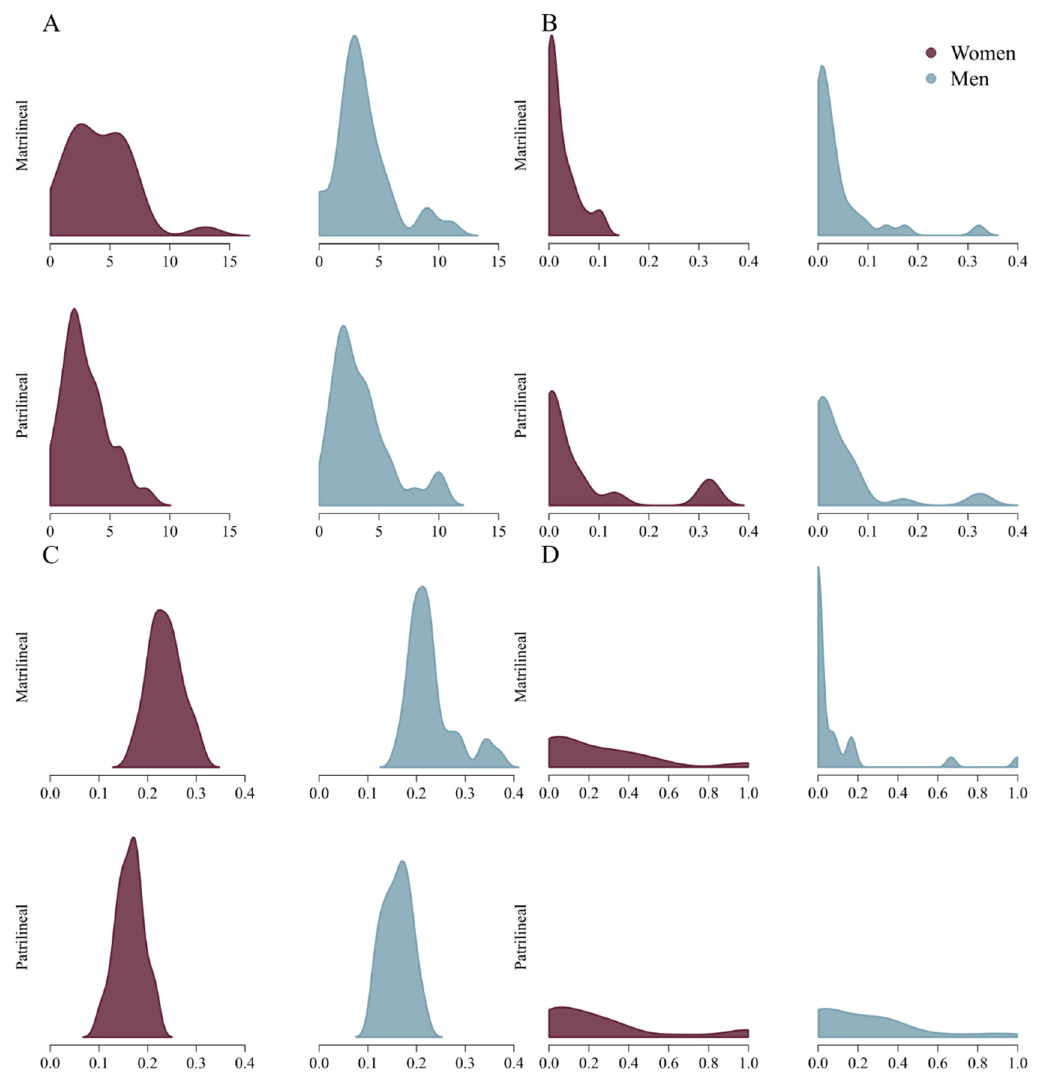
Figure 2. Kernel density plots for women (purple) and men (blue) in matriliny and patriliny, as labeled for ( A ) degree, ( B ) betweenness centrality, ( C ) closeness centrality, and ( D ) transitivity. The modal transitivity for both women and men respondents in both matriliny and patriliny was zero. Matrilineal women had a higher transitivity than matrilineal men ( p <